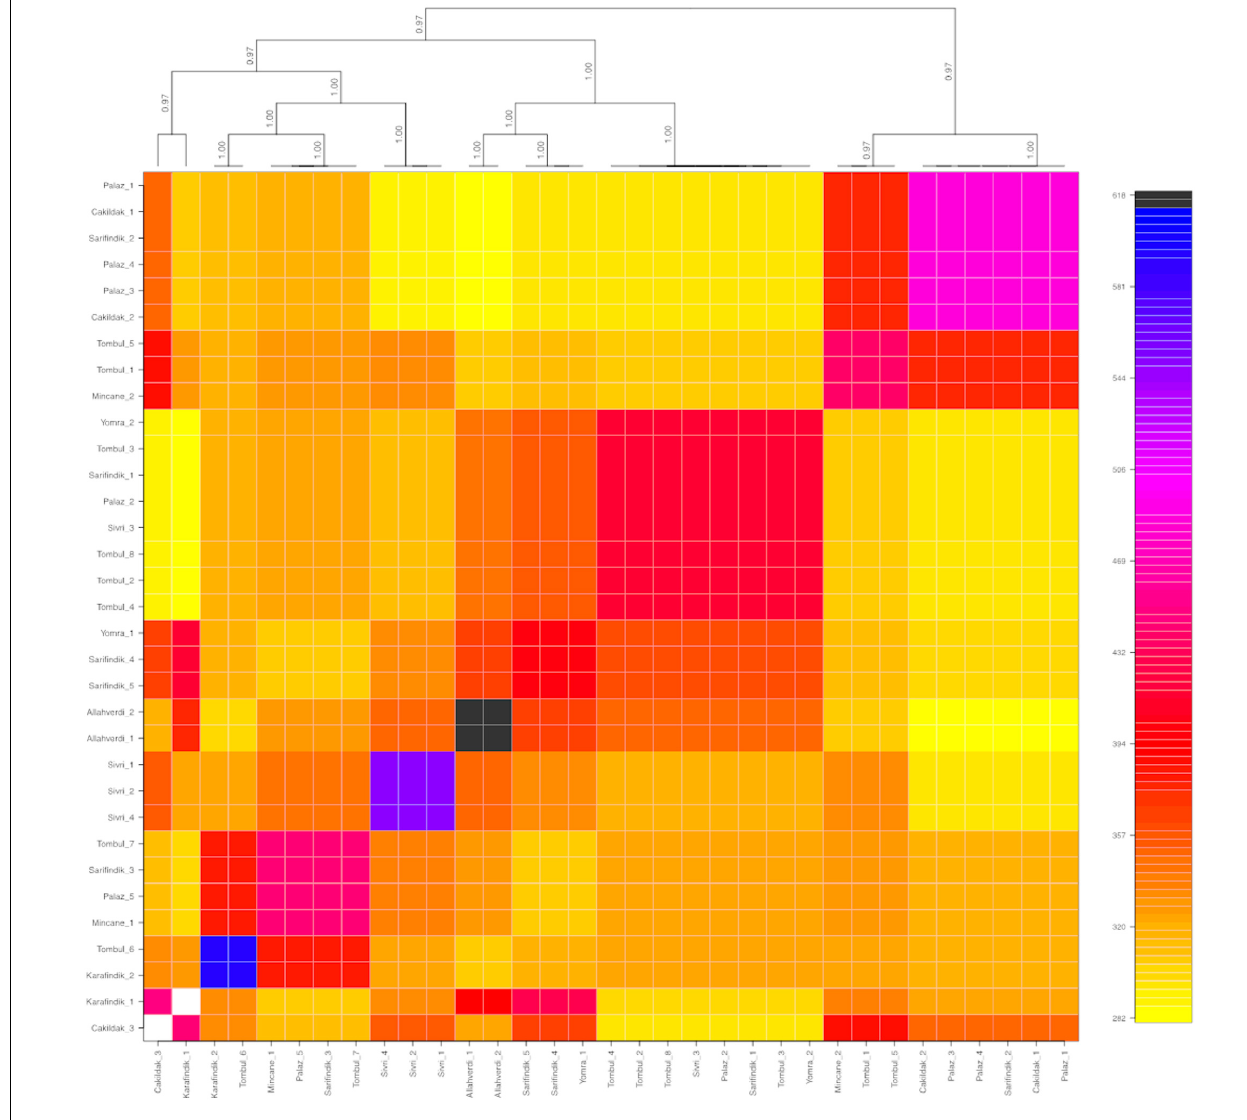
FIGURE 3 | Co-ancestry heatmap and cladogram of hazelnut individuals composing of nine different varieties: ‘Allahverdi’, ‘Çakıldak’, ‘Karafındık’, ‘Mincane’, ‘Palaz’, ‘Sarıfındık’, ‘Sivri’, ‘Tombul’, and ‘Yomra’. The color scale on the right shows the degree of shared co-ancestry. Bootstrap values for the cladogram are indicated on the branches.